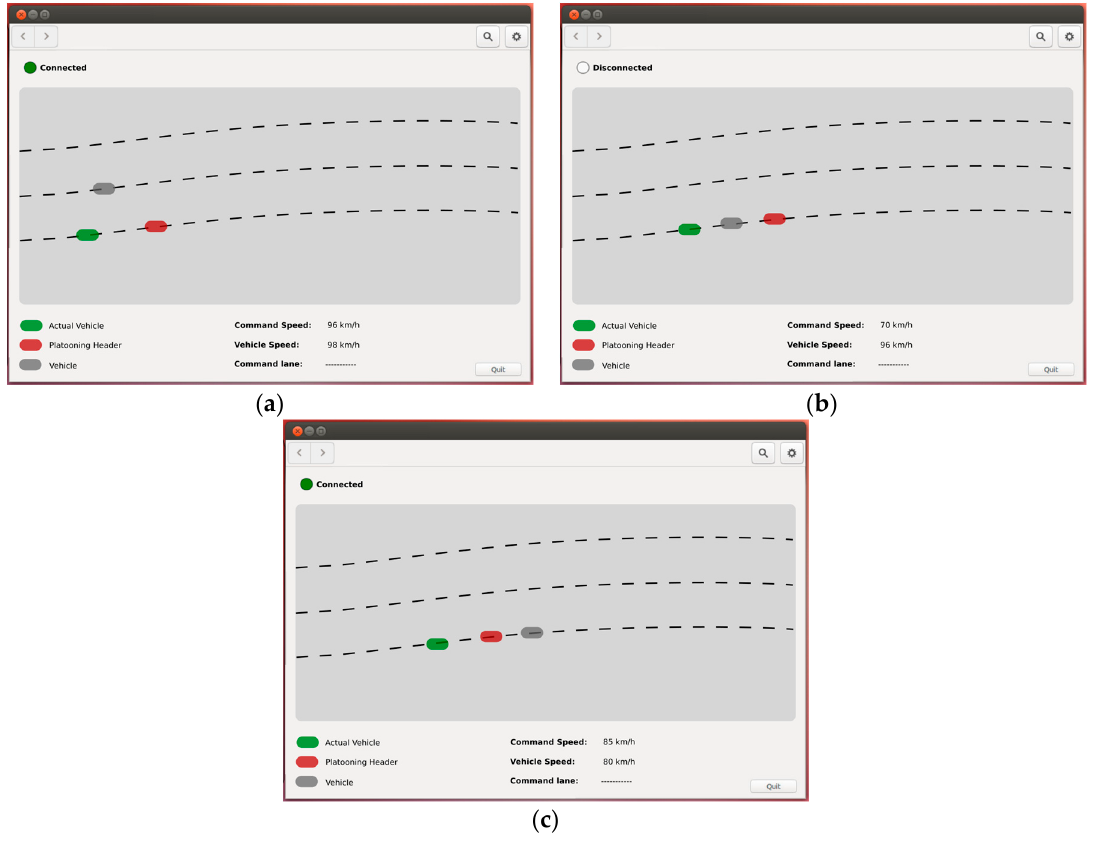
Figure 9. Cut-in maneuver: ( a ) Top left: Screenshot of maneuver start; ( b ) Top right: Screenshot of the cut-in moment; ( c ) Below: Screenshot of the network reconnection. Table 3. Results of the cut-in maneuver